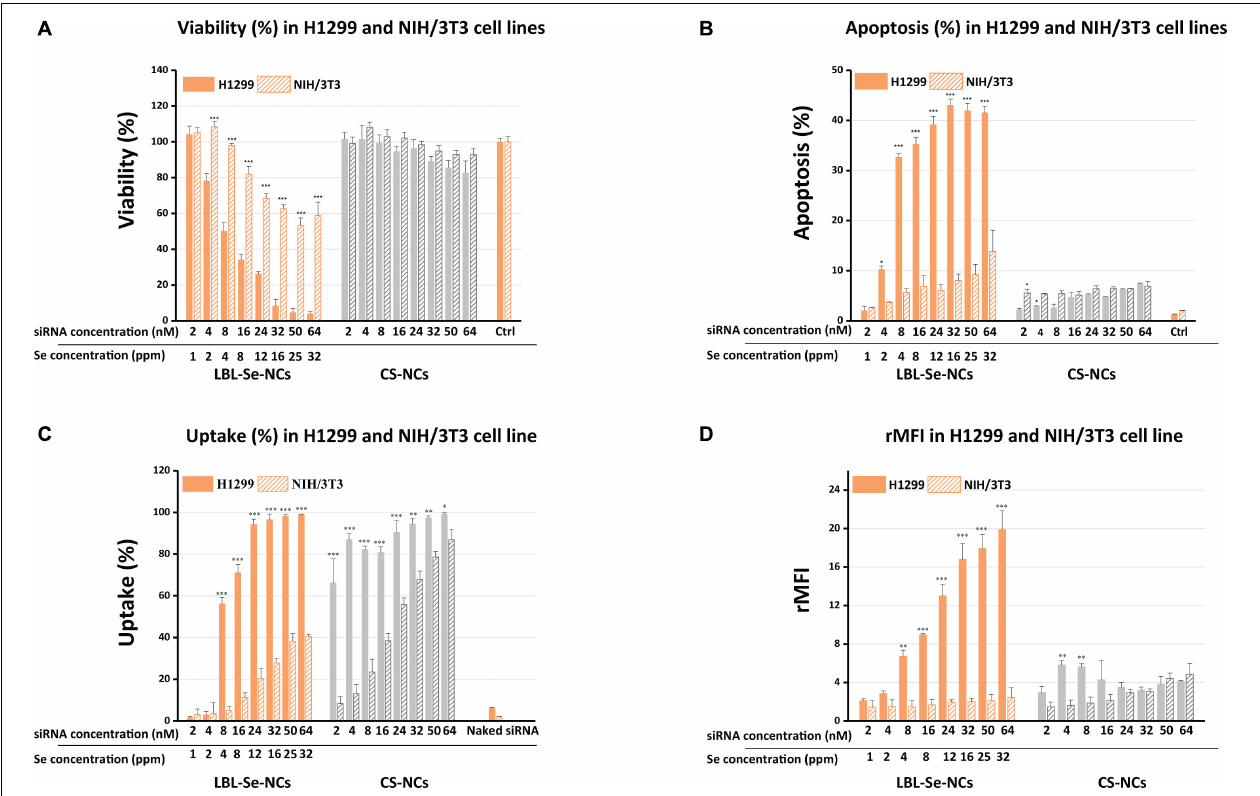
FIGURE 3 | Comparison of biological effect by LBL-Se-NCs and CS-NCs in H1299 and NIH/3T3 cells. (A) Cell viability after treatment of H1299 (cancer cells) and NIH/3T3 (normal cells) with LBL-Se-NCs and CS-NCs. (B) Flow cytometric determination of apoptotic and necrotic populations of cells treated with LBL-Se-NCs in comparison with CS-NCs on H1299 and NIH/3T3 cells. (C) Uptake of AF647 siRNA-loaded Se-NCs and CS-NCs in H1299 and NIH/3T3 cell lines quantified via flow cytometry. ‘Uptake%’ refers to the percentage of cells that are positive for AF647. (D) The corresponding relative mean AF647 fluorescence intensity per cell (rMFI), which is proportional to the amount of particles that are taken up per cell on average. Bars represent mean ± SEM ( n = 3, * p < 0.05; ** p < 0.01; *** p <